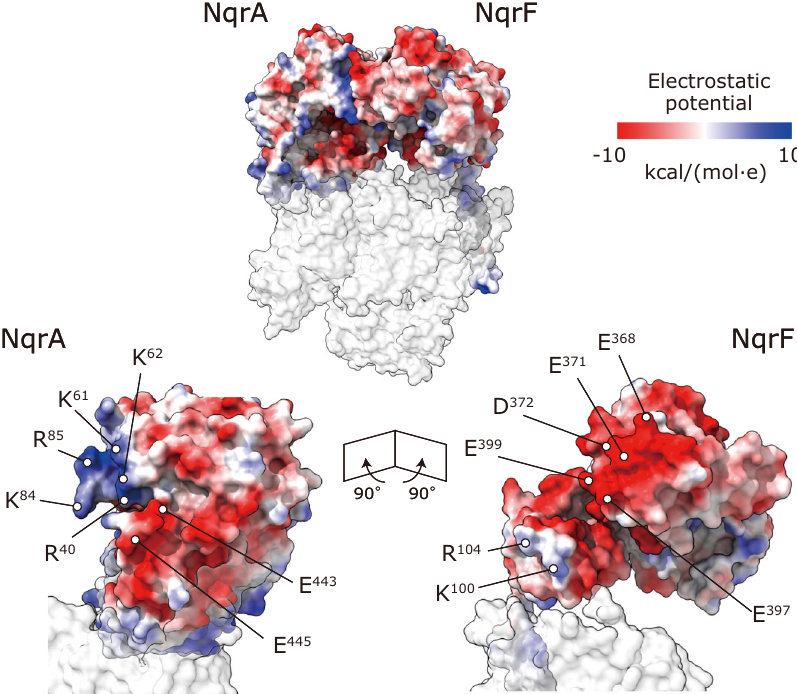
Fig. 2 The cytoplasmic contact area between NqrA and NqrF. NqrF binds tightly to the neighboring hydrophilic NqrA via electrostatic interactions in the state 1 model. Lower panels show cross-section images of the contact area between the two subunits. The positively and negatively charged residues in the NqrA and NqrF are indicated in blue and red ,